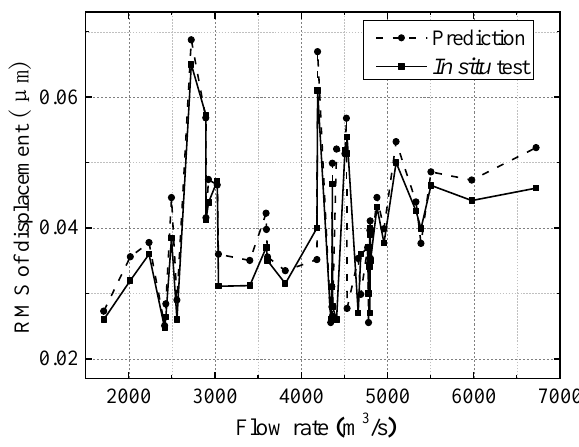
Figure 18. Comparison between prediction and in situ measurement RMS of displacement at T9. Table 3. The comparison between the prediction result and the in situ measurement at different distances from the dam area. Flow Rate